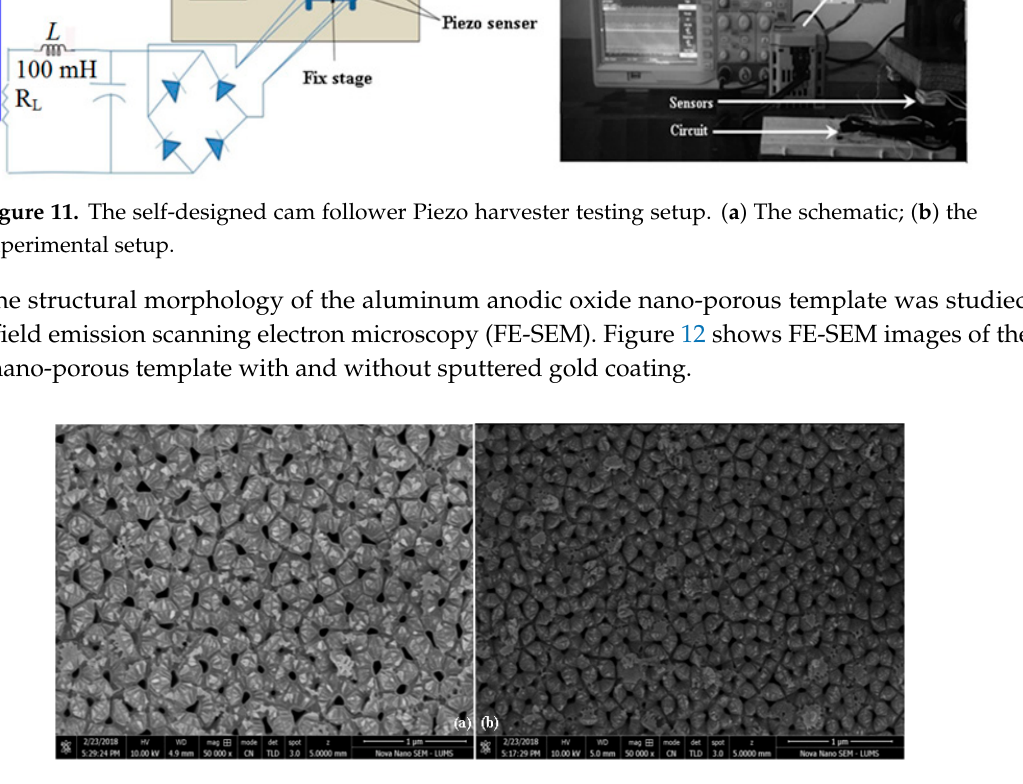
Figure 12. FE-SEM micrographs of the AAO nano-porous membrane ( a ) without gold sputtering ( b ) with gold sputtering.